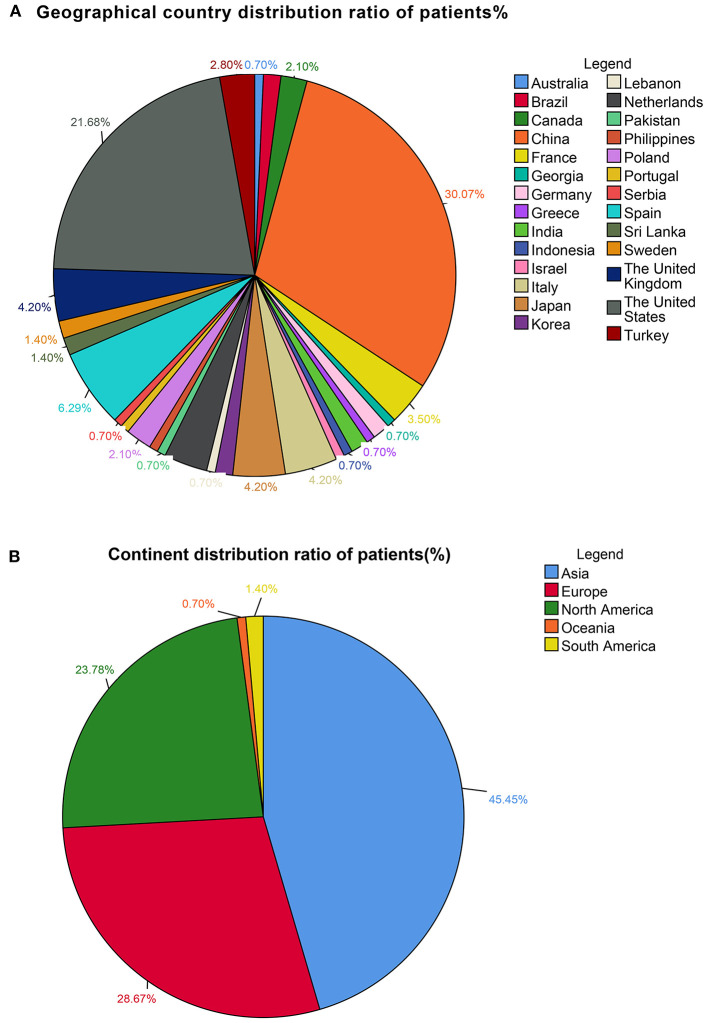
(A) Geographical country distribution ratio among the patients (%). (B) Continent distribution ratio among the patients (%).